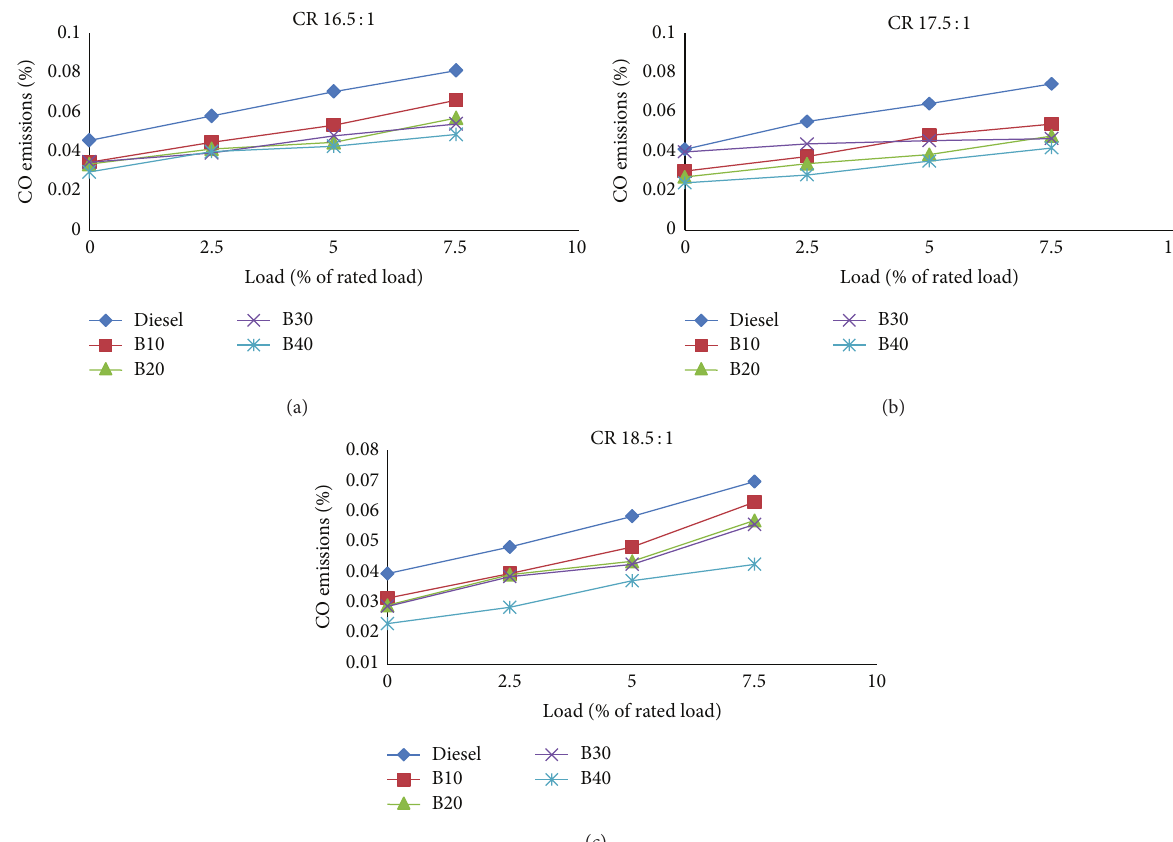
Figure 11: Variation of CO emission with engine load for diesel and all blends of Jatropha ethyl ester at different compression ratios.